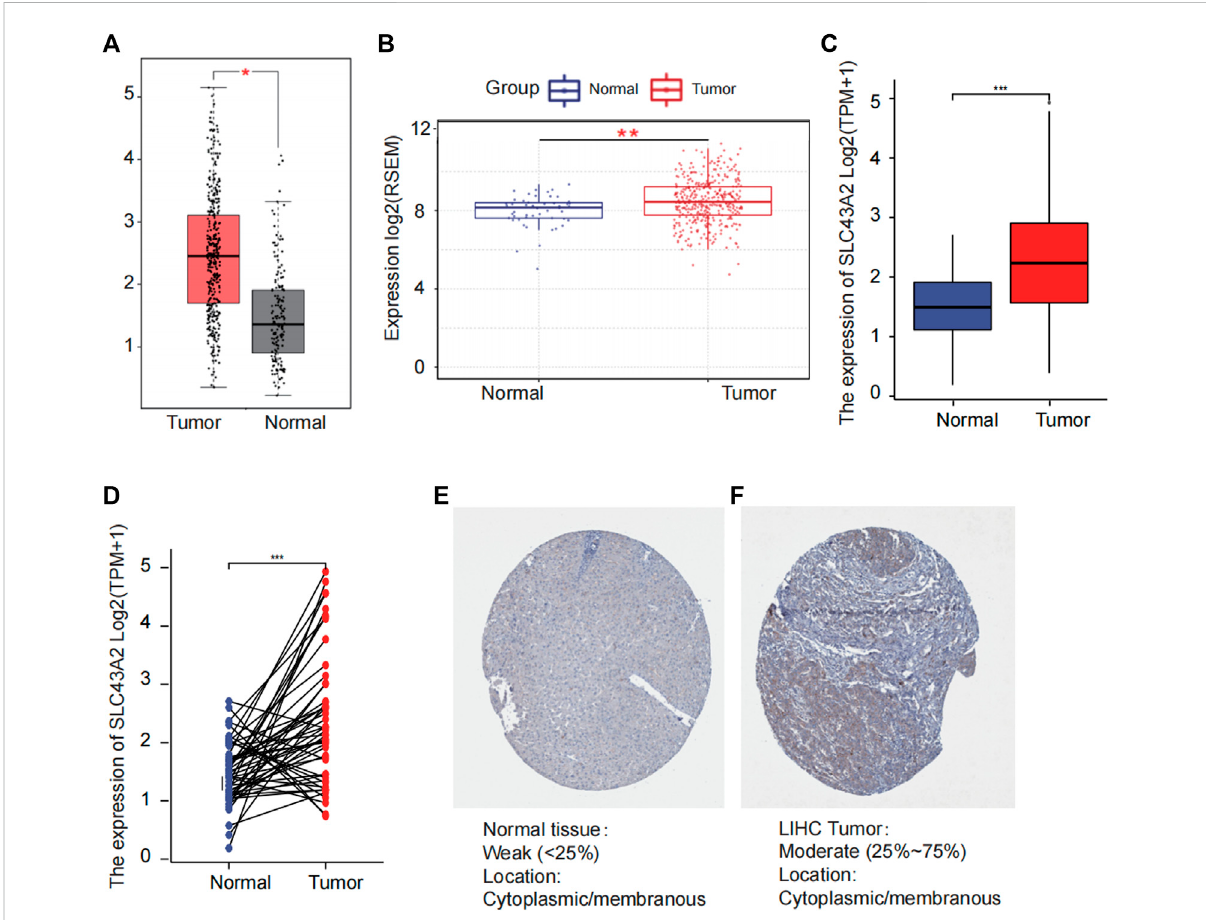
FIGURE 2 Difference of SLC43A2 expression between LIHC and normal tissues. The difference of the mRNA expression of SLC43A2 between LIHC and normal tissues inGEPIA (A) and GSCALite (B) datasets. The mRNAexpression levels ofSLC43A2 in374LIHC samplesand 50normal samples (C) . The mRNA expression levels of SLC43A2 in 50 LIHC and matched-adjacent normal samples (D) . The difference of protein levels of SLC43A2 between LIHC and normal tissues based on HPA (E, F) . (ns, no signi fi cance, p ≥ 0.05; * p < 0.05; ** p < 0.01; *** p <